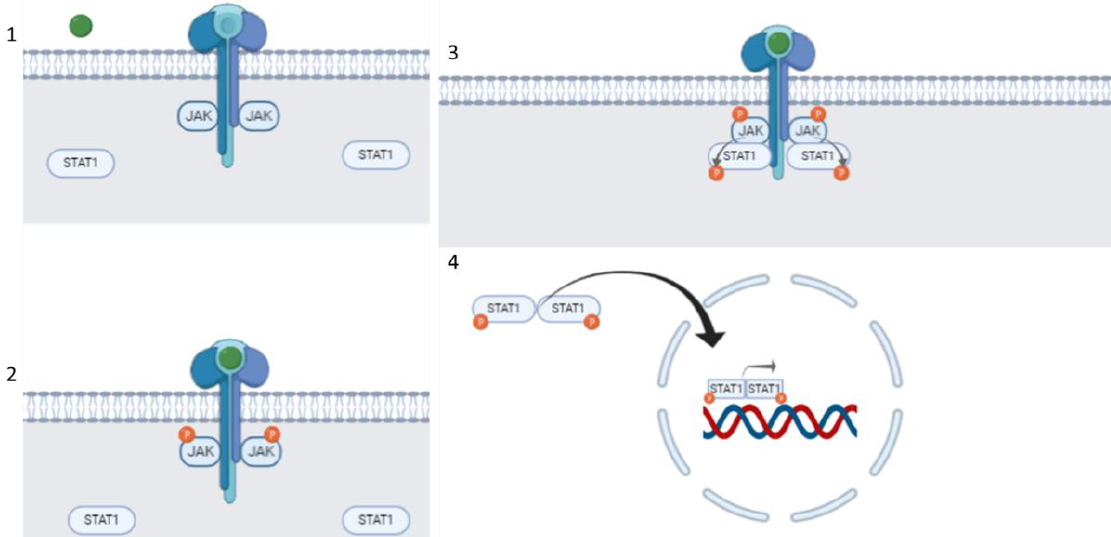
Figure 2 . JAK/STAT signaling pathway. The cell ligand interacts with its receptor to cause receptor dimerization. The connection between the ligand and the receptor induces transphosphorylation of JAK. Activated JAK causes tyrosine phosphorylation of the bound receptor, forming a docking site for STATs. In the next step, JAK phosphorylates STAT, and then STAT dissociates from the receptor and forms homodimers or heterodimers through SH2-domain – phosphotyrosine interactions. These dimers translocate to target gene promoters, regulating the transcription of the target genes [11,72]. Steps are as follows: (1) Ligand binds to the receptor, (2) JAK auto-phosphorylates, (3) STAT binds to JAK and JAK phosphorylates STAT, (4) STAT forms homo-dimer; therefore, the homo-dimer enters the nucleus, binding to DNA, targeting gene